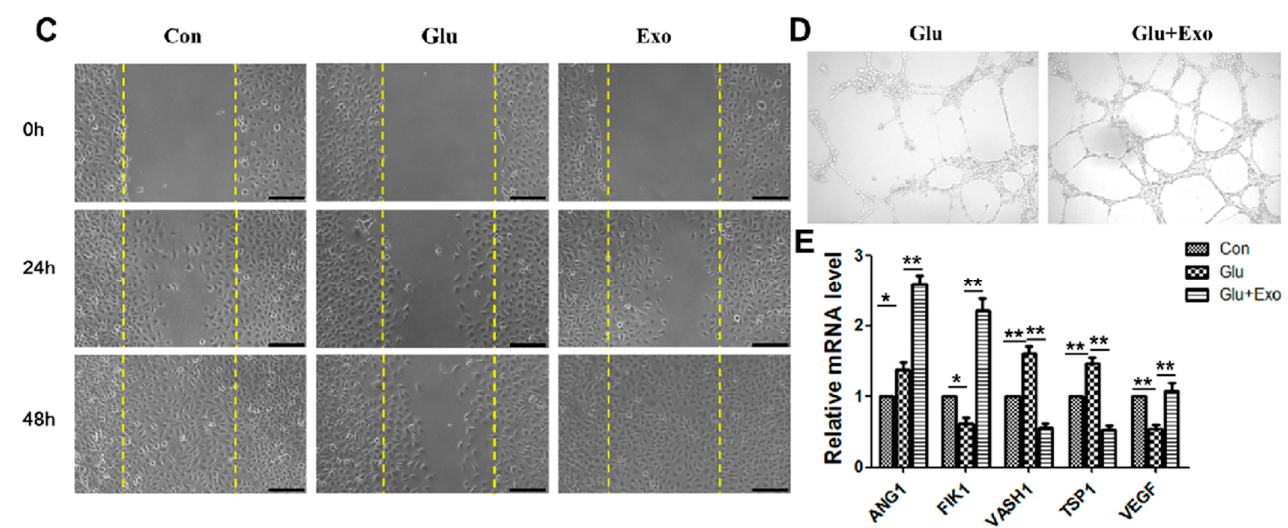
Figure 3. The effect of ADSC-exos on HUVECs. ( A ) Representative immunofluorescence images of PKH26-labelled exosomes in HUVECs. ( B ) The effect of ADSC-exo concentration on HUVECs activity was determined by CCK-8 assays. ( C ) The effect of ADSC-exos on HUVECs migration in a high-glucose environment was examined by scratch wound assays. The cells were divided into a normal control group, a high glucose control group, and an ADSC-exo-treated high glucose group. The images show the wound area in each group at 0 h, 24 h, and 48 h (scale = 250 μ m). ( D ) Angiogenesis in different groups. The results showed that ADSC-exos enhanced angiogenesis in HUVECs. ( E ) mRNA levels of angiogenesis factors (ANG1, FILK1, and VEGF) and angiogenesis inhibitors (VASH1 and TSP1) were analyzed by qRT-PCR. The data are shown as the mean ± SD (* p < 0.05, ** p < 0.01).